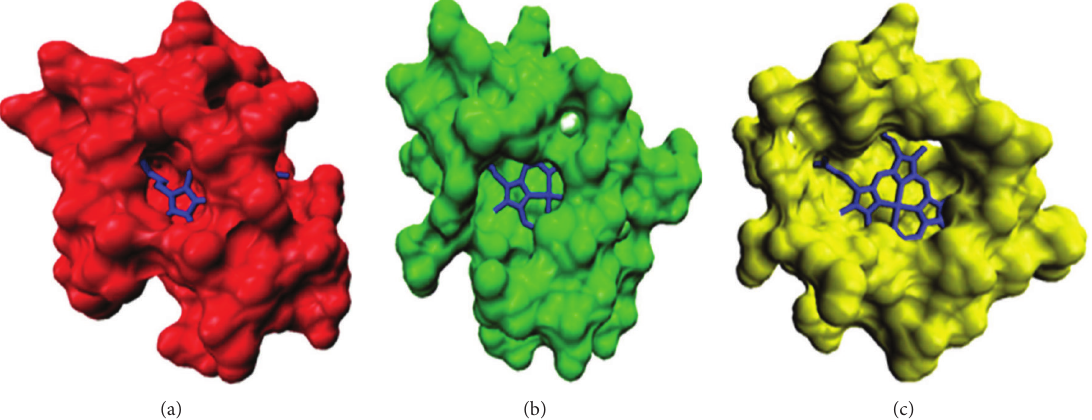
Figure 1: Active site of CYPs. Surface presents the active site of (a) CYP2B6, (b) CYP2D6, and (c) CYP3A4. Heme is in blue stick representation. Figure was generated using VMD1.8.7 [9].